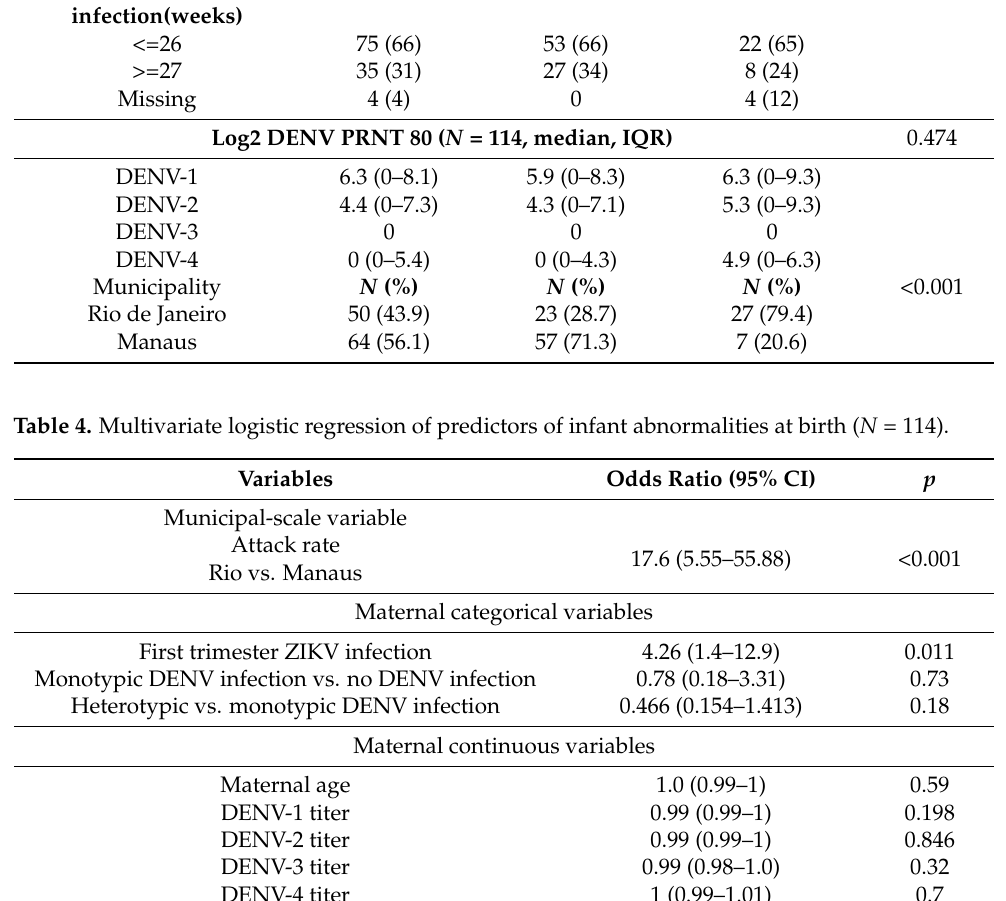
Infant Outcomes